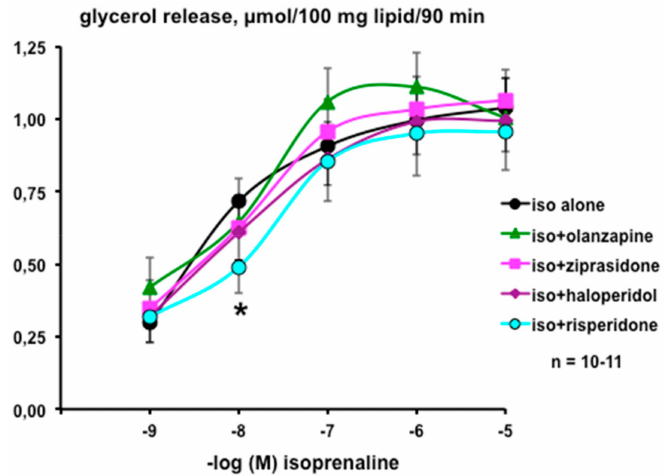
Figure 1. Dose–response curves for isoprenaline stimulation of lipolysis in human subcutaneous adipocytes in the presence of antipsychotic drugs. Each point is the mean ± SEM of 10–11 determinations, performed in control conditions with isoprenaline alone (iso alone, black circles) or in combination with 100 µ M of the indicated drugs. A significant di ff erence from the corresponding control lipolytic response was found only in the presence of risperidone (iso + risperidone, blue circles), at: * p <